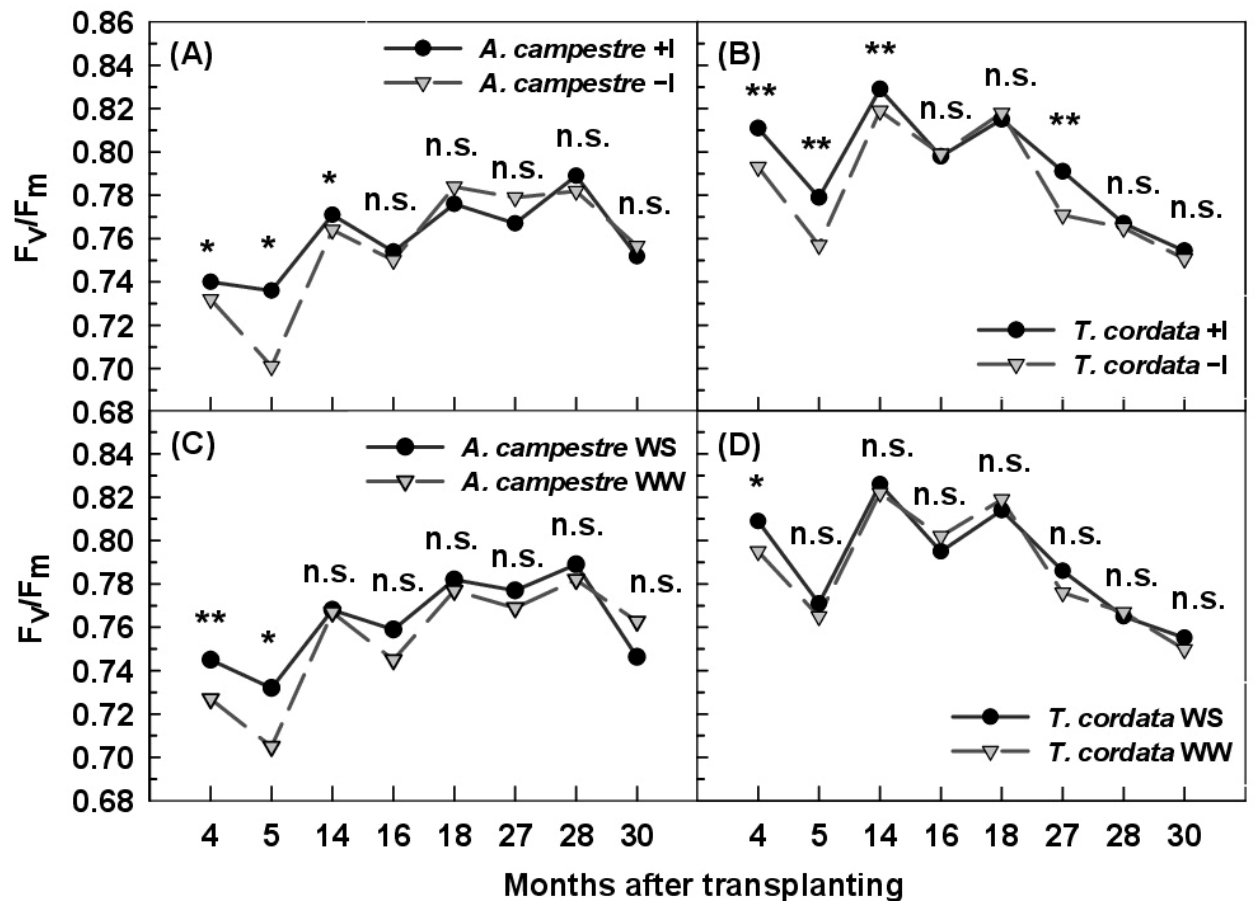
Figure 4. Effect of mycorrhizal inoculation and water regime in the nursery on maximal quantum yield of PSII (F v /F m ) of Acer campestre L. (A and C, respectively) and Tilia cordata Mill. ( B and D, respectively) transplanted in the field. Within each panel and sampling date, * and ** indicate significant differences between +I (inoculated) and − I (non-inoculated) plants and between WW (well-watered) and WS (water-stressed) plants at p ≤ 0.05 and p ≤ 0.01, respectively; n.s. indicates no significant differences.